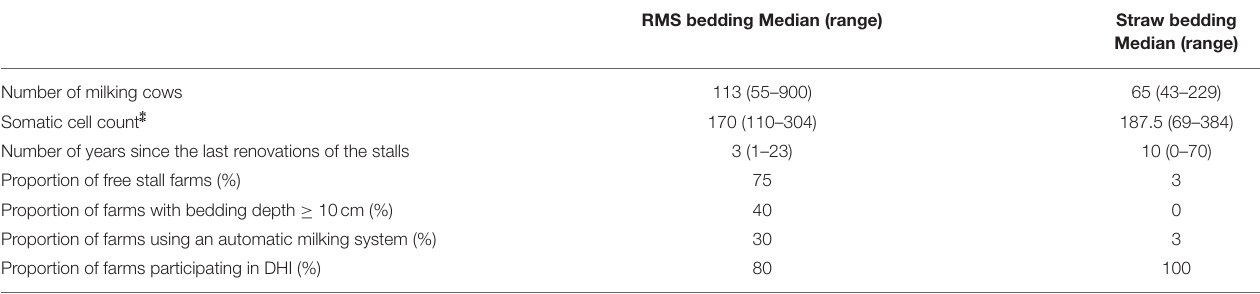
TABLE 1 | Description of the 20 recycled manure solids farms and 60 straw farms with SCC data included in the study on subclinical mastitis.